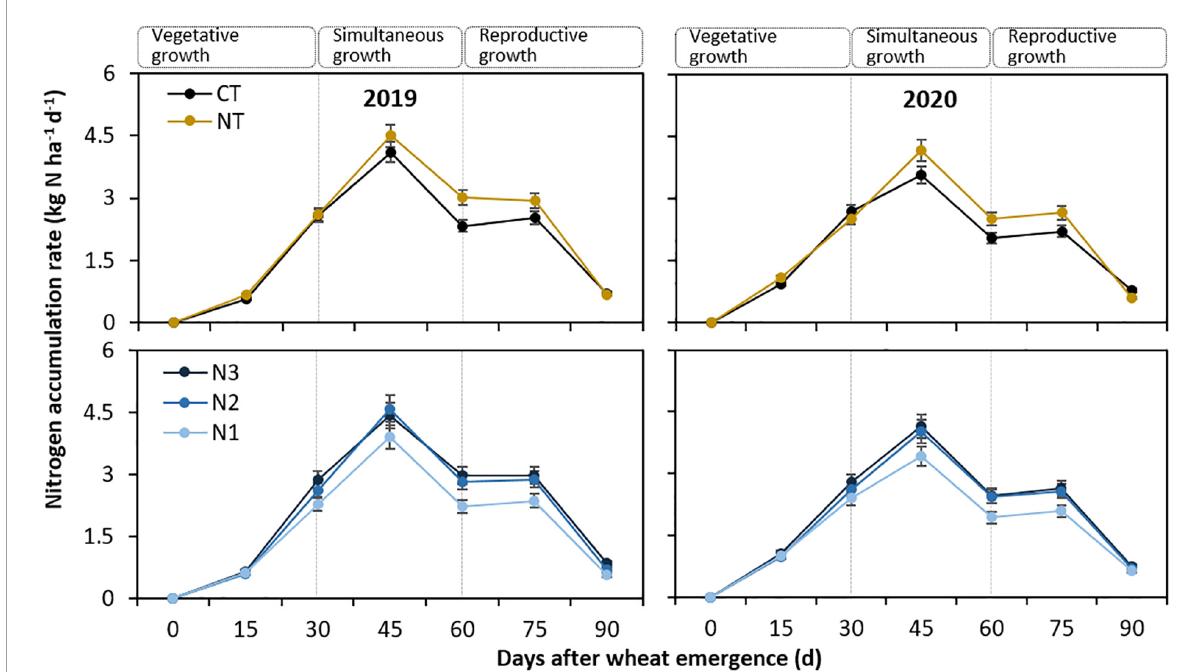
FIGURE1 Nitrogen accumulation rate (NacR) of spring wheat with two tillage practices and three N fertilizer rates in 2019 and 2020. CT and NT represent conventional tillage without plastic film mulching and no-till with previous plastic film mulching. N1, N2, and N3 represent N fertilizer applied at 135, 180, and 225 kg N ha –1 , respectively. The smaller bars are standard error of means ( n = 3).